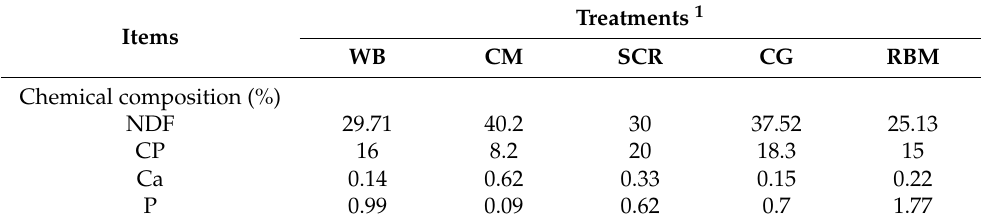
Table 2. Composition analysis of fiber sources in the